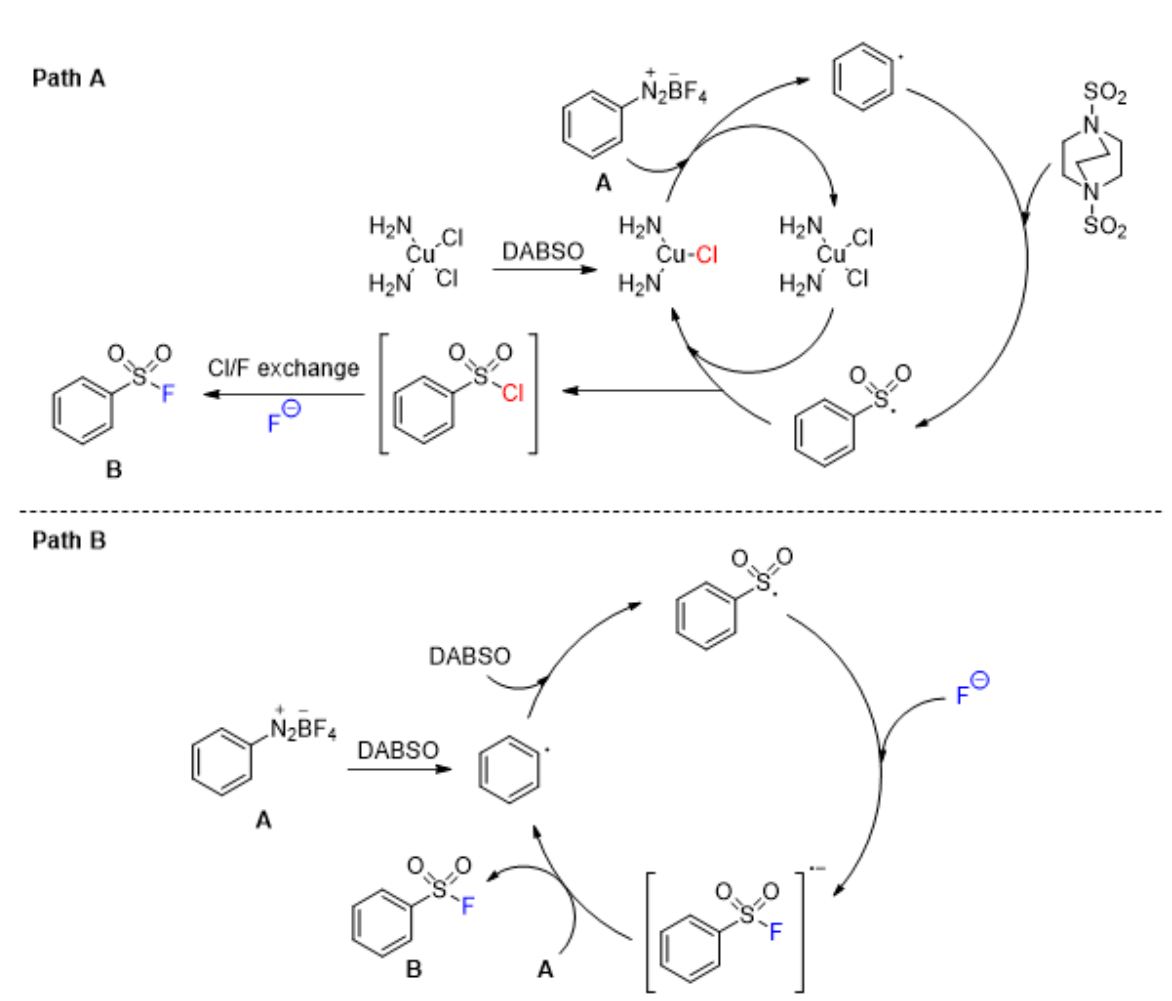
Scheme 9. Proposed mechanism for the synthesis of arylesulfonyl fluorides via